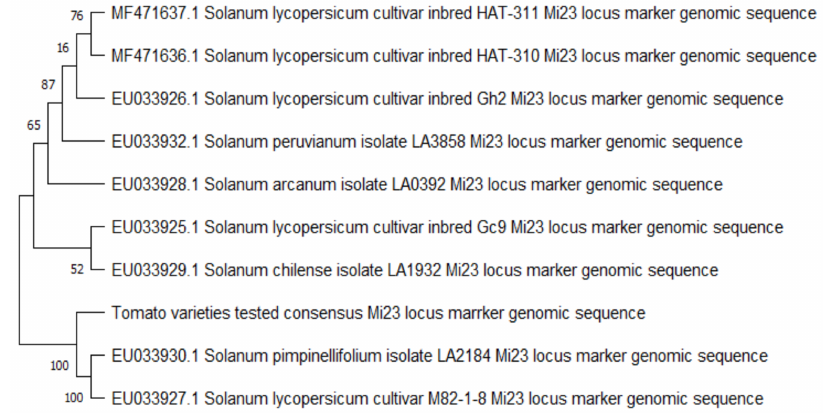
Figure 3. Phylogenetic analysis using the neighbor-joining method, showing the clustering of the consensus genomic sequence obtained using the Mi23 locus marker in the tested tomato varieties, along with reference sequences of tomato genotypes and wild relatives reported to have resistance or susceptibility to root-knot nematodes.